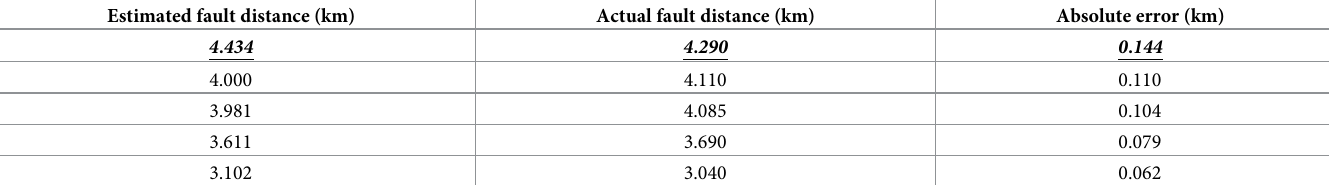
Table 8. Fault distance estimation (CGF).